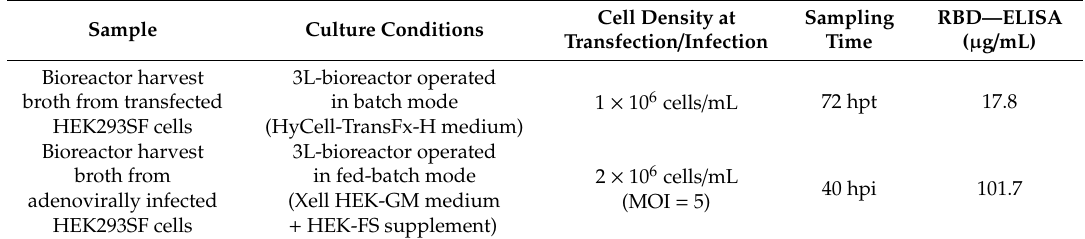
Table 2. RBD expression levels determined by ELISA in the supernatant of HEK293SF cells cultured